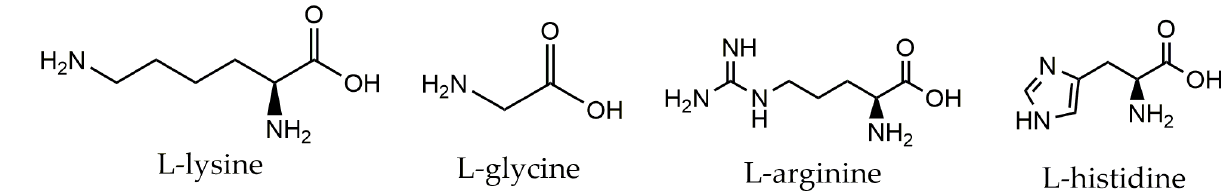
Figure 8. Chemical structure of L-lysine, L-glycine, L-arginine, and L-histidine.